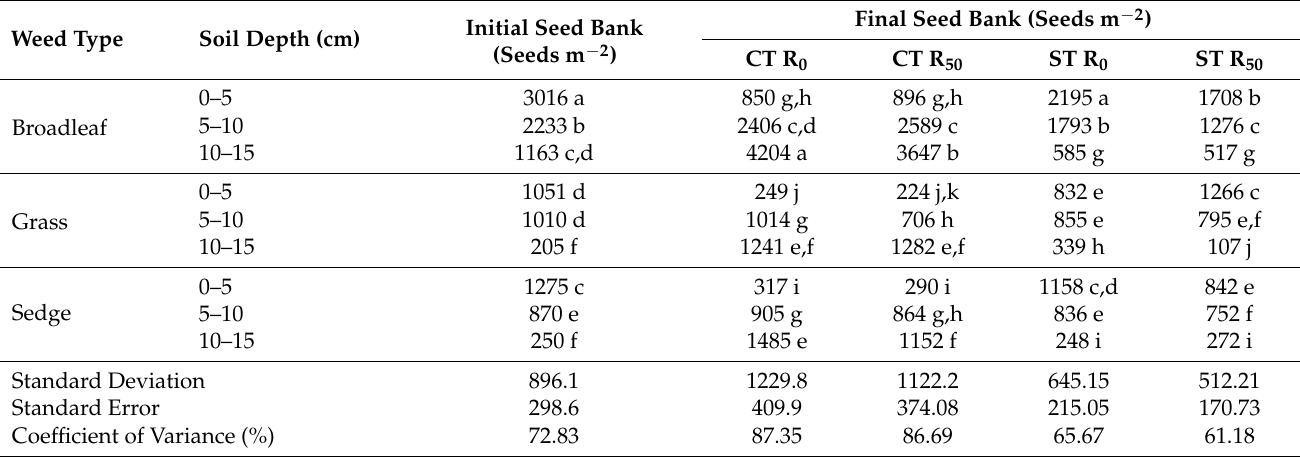
Table 8. Effect of tillage and residue levels on the weed density (plant m − 2 ) as a group at different soil depths (on average